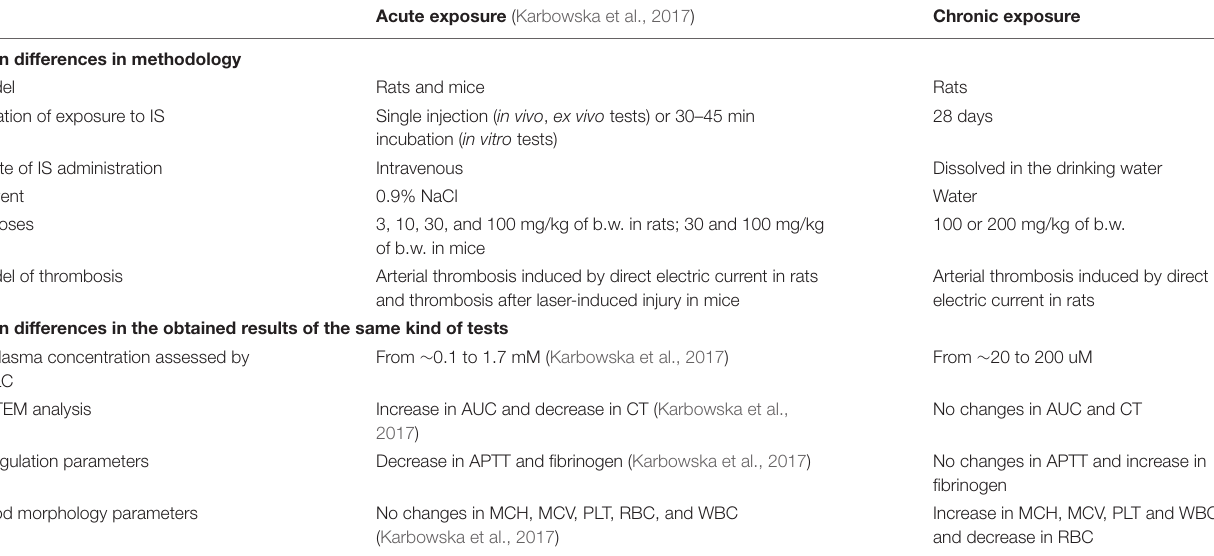
TABLE 1 | Differences between acute and chronic exposure to indoxyl sulfate in animal model. Acute exposure (Karbowska et al.,